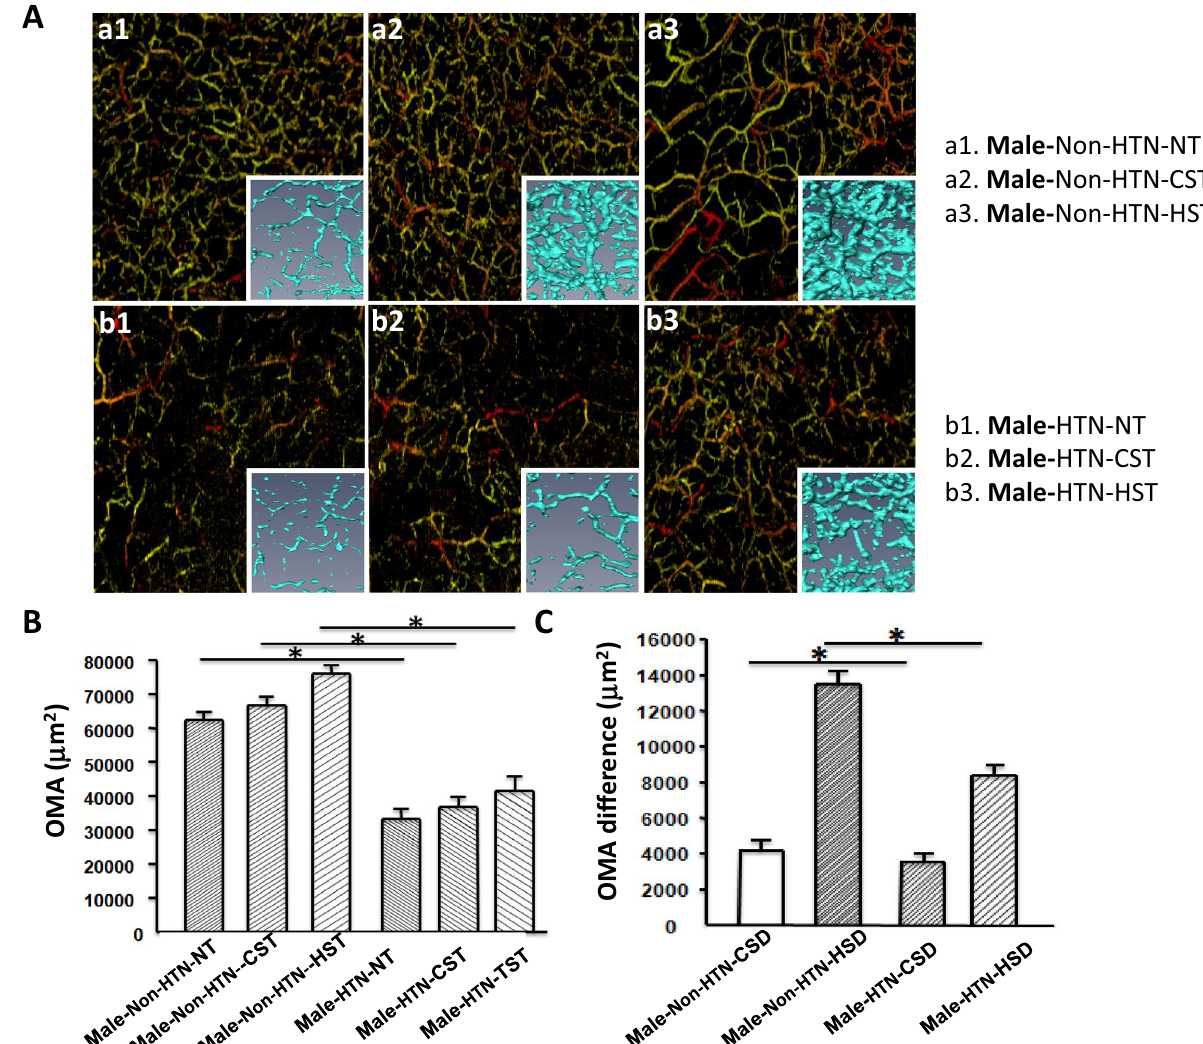
Figure 3. ( A ) Microvascular network imaging under the back of the hand, three-dimensional blood vessel model imaging, a1 NT, a2 CST, a3 HST in non-HTN, b1 NT in male HTN, b2 CST in male HTN, b3 HST in male HTN; ( B ) Variance histogram of blood vessel area; ( C ) Difference of blood vessel area Variance histogram; non-HTN n = 18, HTN n = 25, *mean NT, CST, HST, CSD, HSD in non-HTN and NT, CST, HST, CSD, HSD in HTN, p <